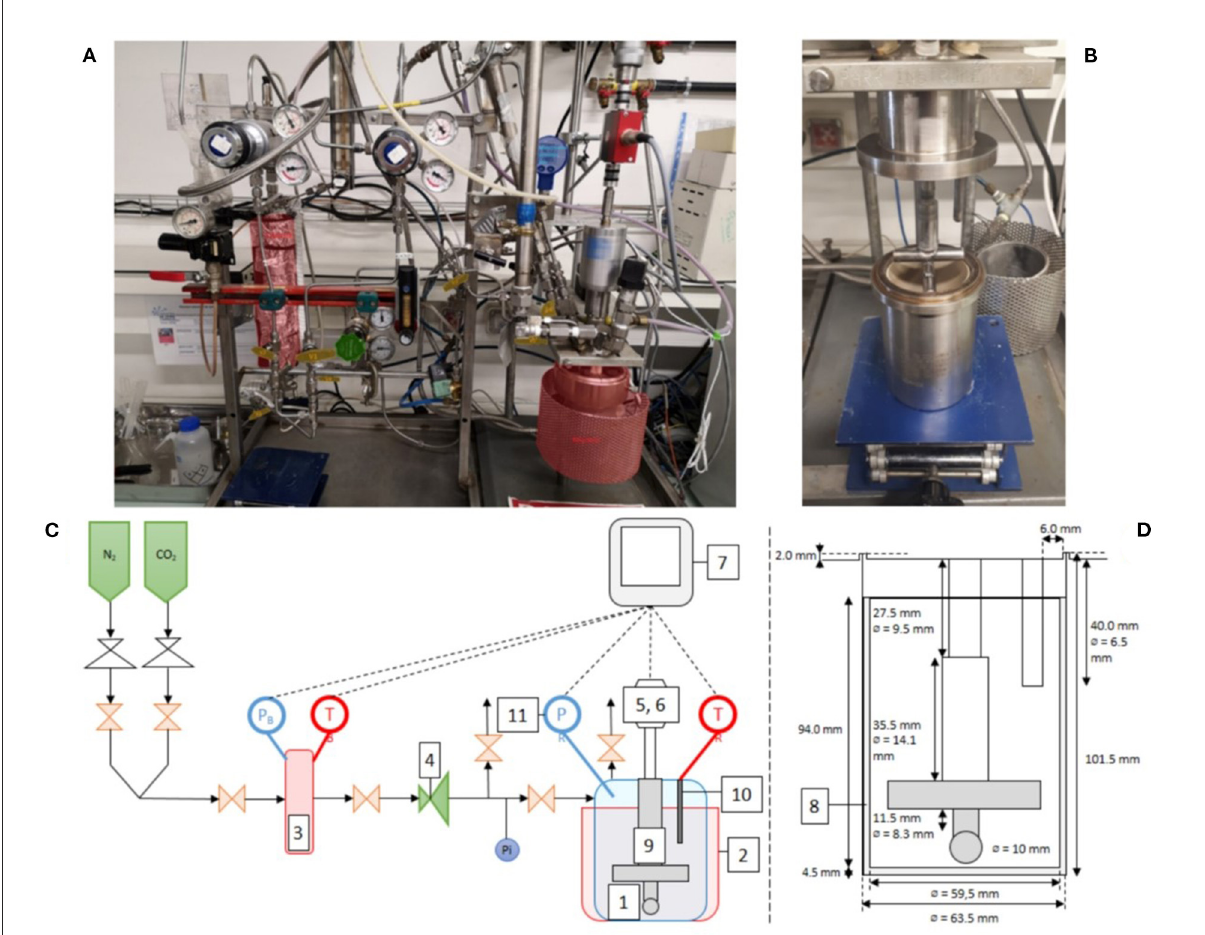
FIGURE3 Photographs and schematics of the attrition-carbonation reactor: (A,C) overview and (B,D) detail of the attrition system: (1) Hastelloy ® autoclave reactor, (2) annular furnace, (3) gas supply tank with temperature probe and pressure transducer, (4) pressure regulation valve, (5) tachymeter, (6) torque meter, (7) HMI system for control and data acquisition, (8) peek liner, (9) impeller, (10) immersion sleeve with Pt100 probe, (11) pressure